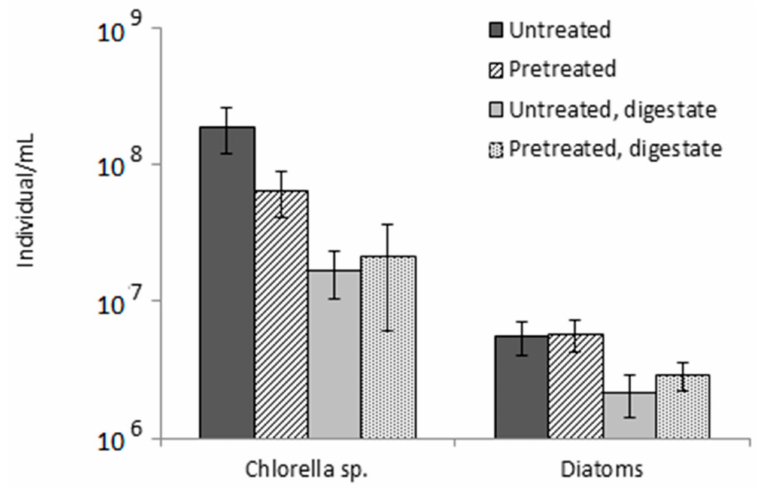
Figure 4. Chlorella sp. and diatoms counting in the influents (untreated; pretreated) and effluents (untreated digestate; pretreated digestate) during Period II. Mean values and standard deviation are